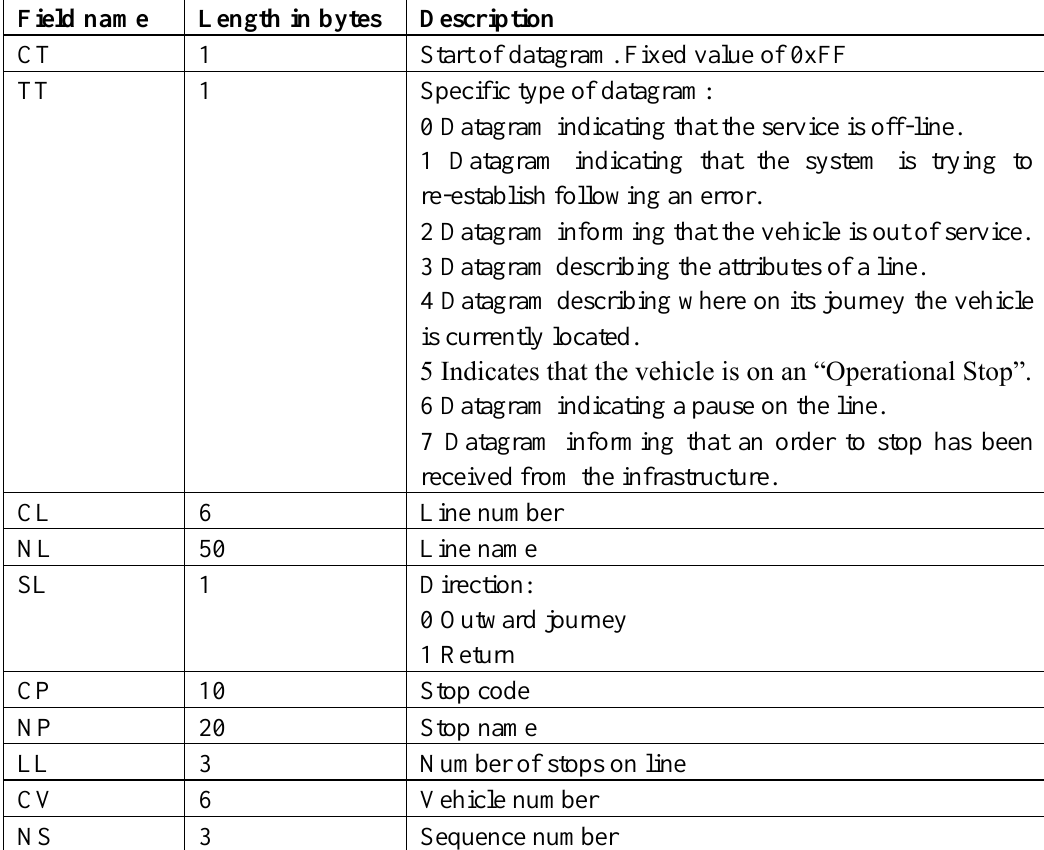
Table 2. Description of the fields used by the different datagrams.